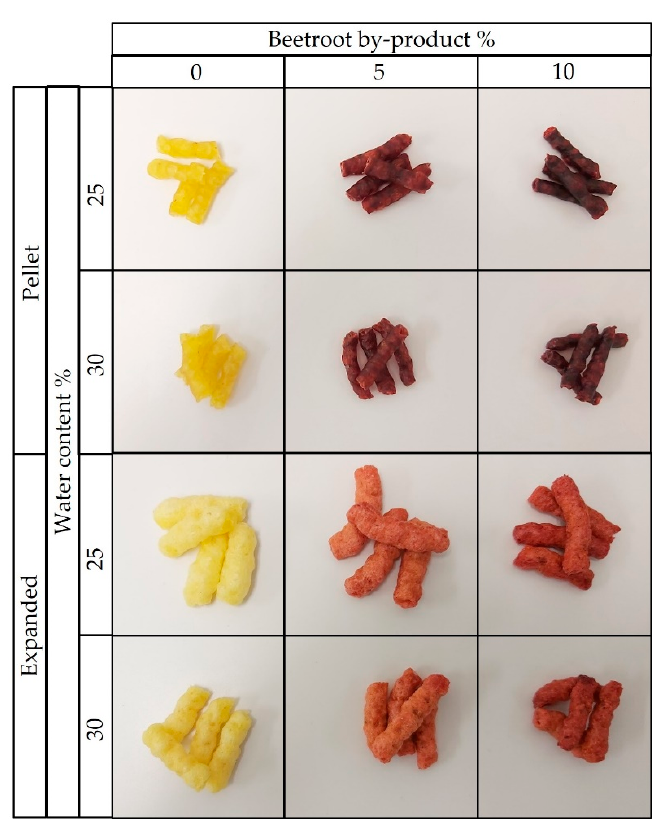
Figure 6. The appearance of pellets after extrusion and drying and expanded products by micro- waves. They are shown at two moisture levels (25% and 30%) and three percentages of beetroot byproduct (0, 5 and